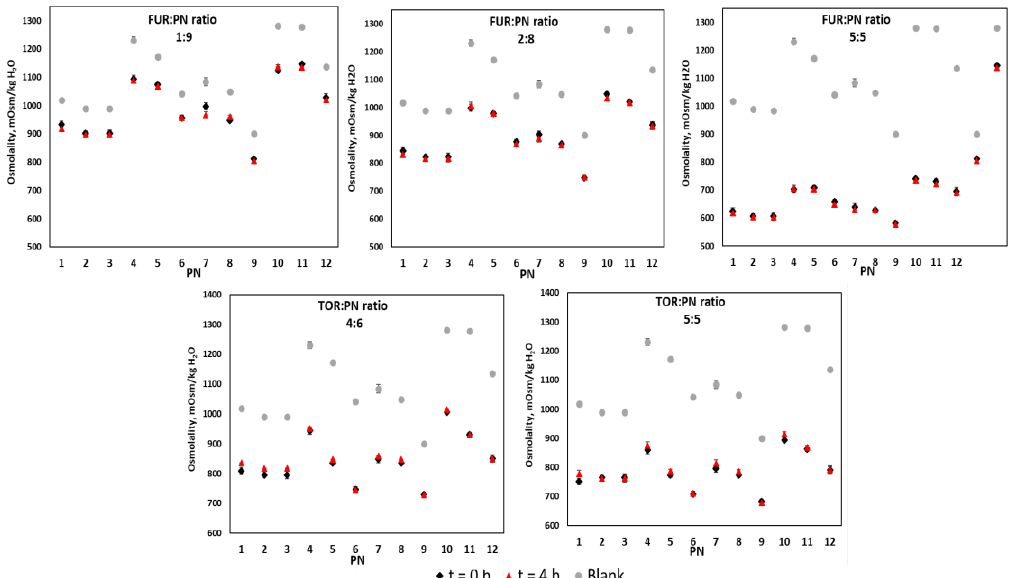
Figure 4. The osmolality of drug–PN samples upon preparation and 4 h later (black and red signs), and PN upon preparation (gray signs). The upper part refers to FUR:PN samples in three different ratios, whereas the down part refers to TOR:PN samples in two ratios. FUR, furosemide; PN, parenteral nutrition admixture; TOR, torsemide; Blank, PN without drug.